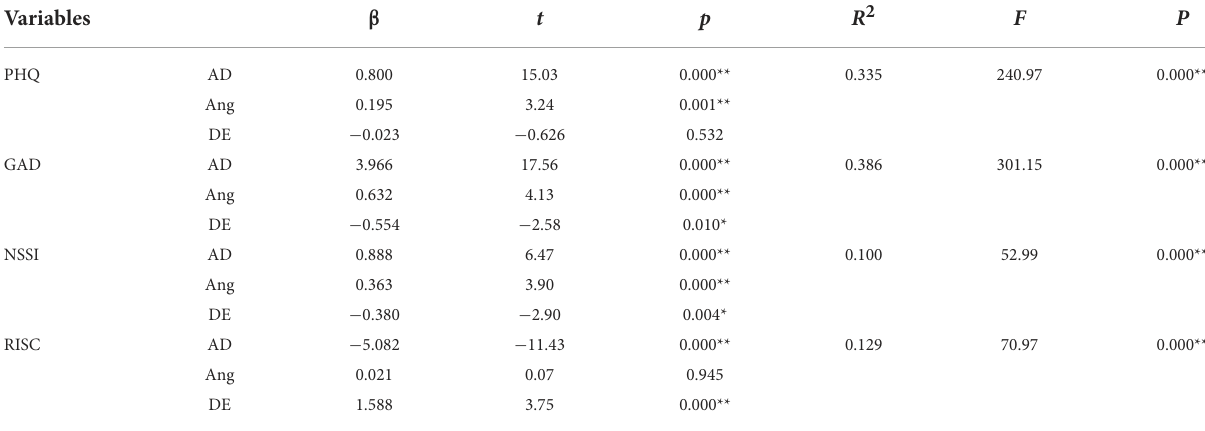
TABLE 7 Multiple linear regression analyses on the effect AD, and DE on PHQ, GAD, NSSI and RISC.